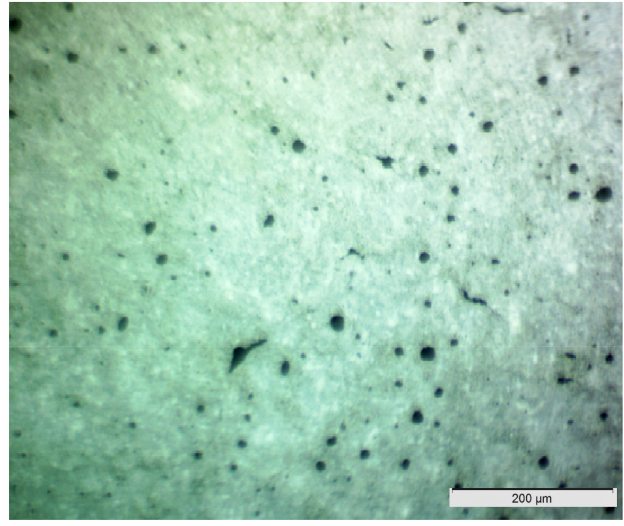
Figure 13. A typical microscopic image of the exterior surface of an aerated slurry with higher compressive